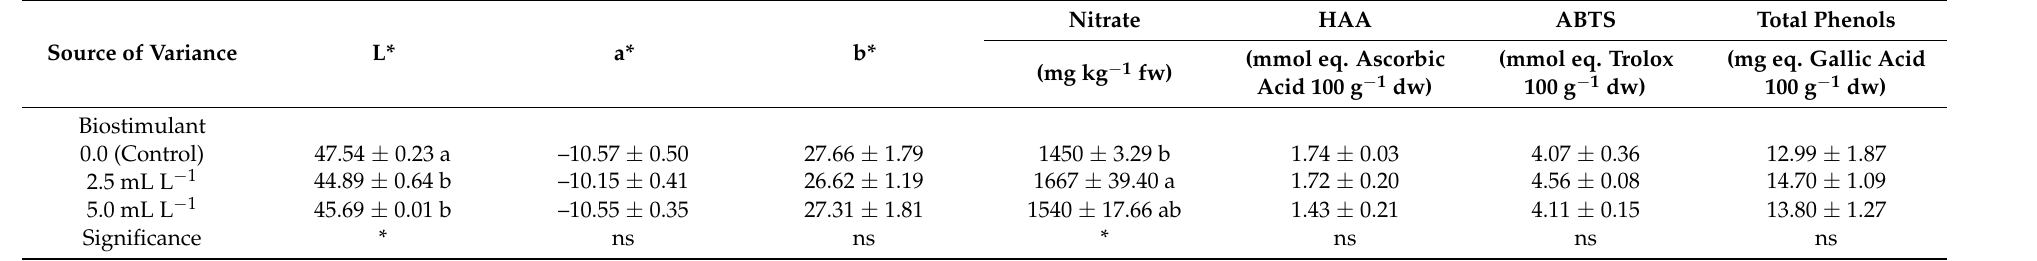
Table 2. The analysis of variance and mean comparisons for leaf color, nitrate, antioxidant activities, and total phenols of greenhouse lettuce cultivated under three biostimulant doses.